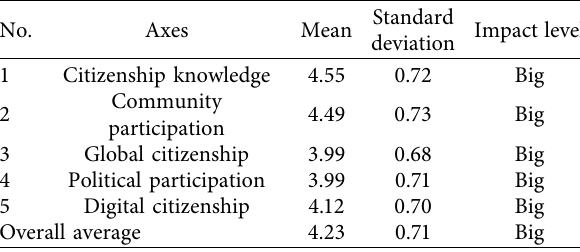
Table 2: Arithmetic averages and standard deviations of the questionnaire axes and the general mean of the